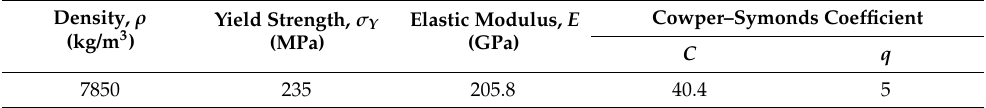
Table 2. Material properties applied to the target